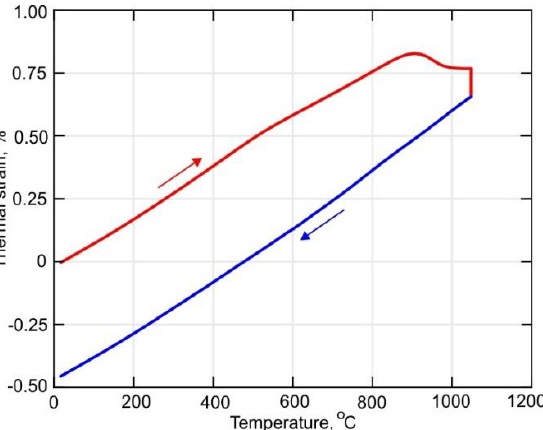
Figure 13. Temperature-dependent thermal strain curve of the DLD-processed Ti-6Al-4V alloy.